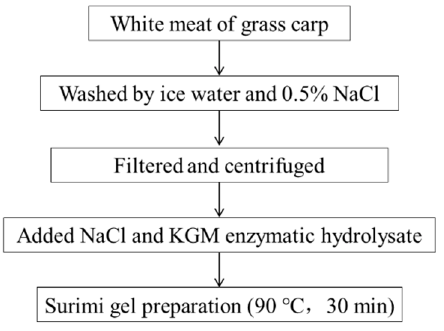
Figure 1. Experimental design of surimi gel with KGM